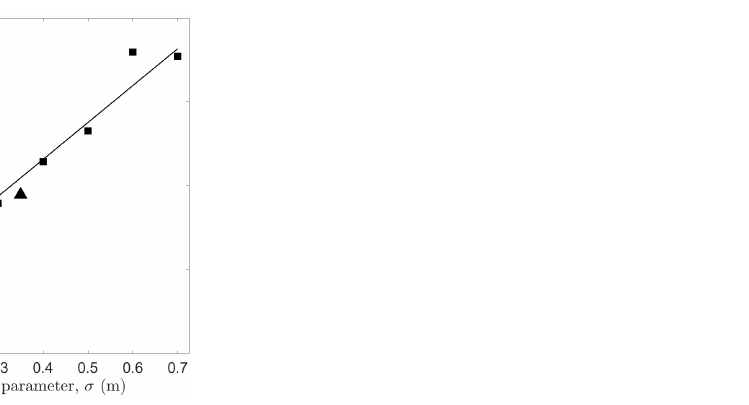
Figure 13. Comparison of the first crest’s amplitude ( A m ,1 ) with the second crest’s amplitude ( A m ,2 ) recorded at x = 7 m under various slide shape parameter, σ . (cid:4) : model predictions. (cid:78) represents the result by the reference solid slide used in the laboratory experiment. Line: linear regression